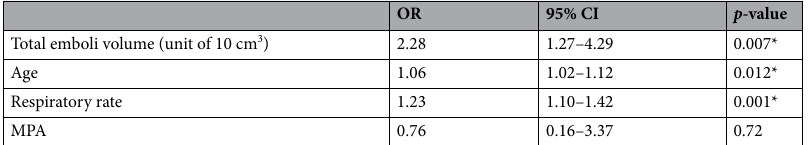
OR 95% CI p -value Total emboli volume (unit of 10 cm 3 ) 2.28